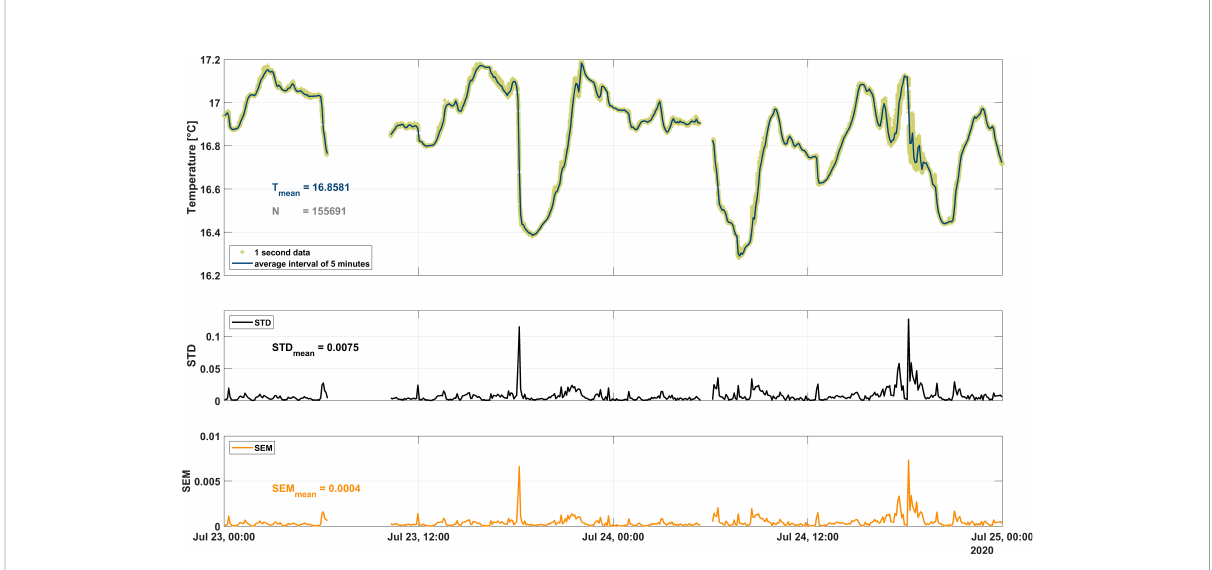
FIGURE 4 Example of measured temperature data from a single sensor (Sensor 1) for period P1. The upper panel shows the temperature data (grey markers indicate the raw data and the blue line indicates the averaged 5 min data sets. The lower panels show the STD (black line) and the SEM (orange line) for the corresponding 5 min averaging intervals). Numbers in the colours of the respective lines indicate the values of the averaged statistical parameters for the complete 5 min